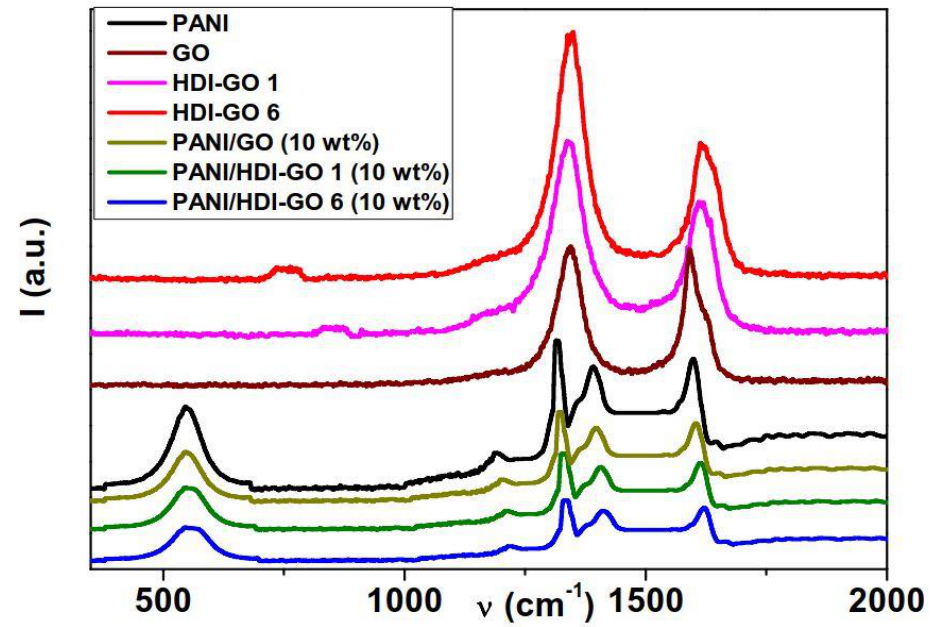
Figure 3. Raman spectra of neat PANI, raw GO, HDI-GO 1, HDI-GO 6, and the corresponding nanocomposites with 10 wt % nanofiller content.